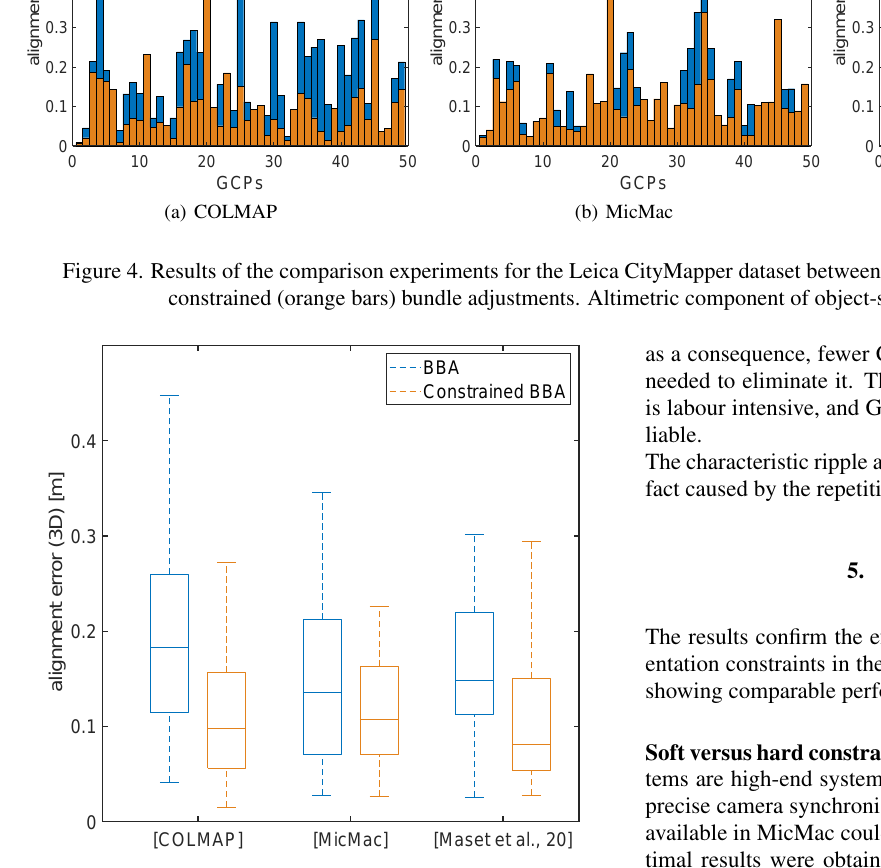
Figure 5. Leica CityMapper: boxplot of 3D object-space errors provided by the three considered